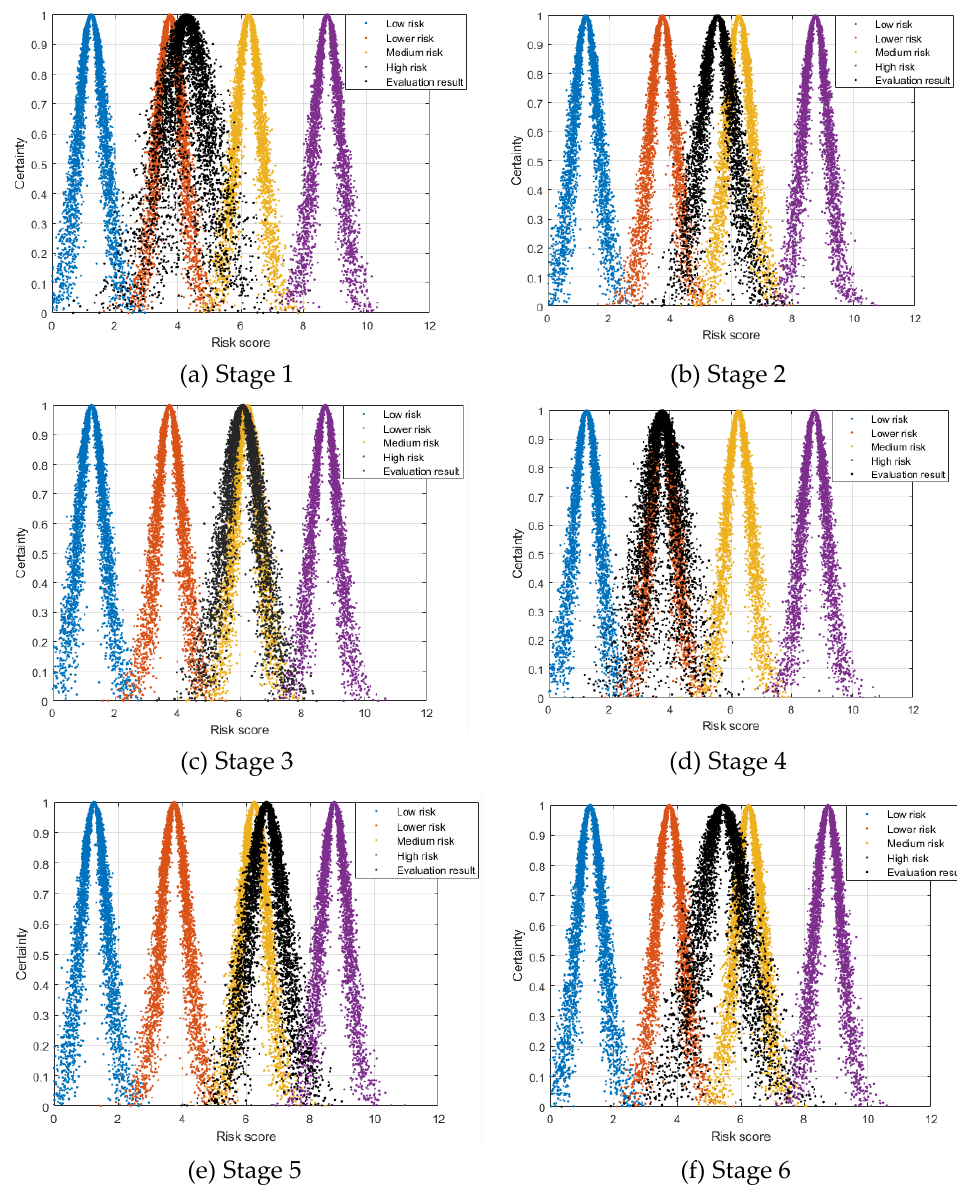
Figure 4. Cloud Chart of Primary Indicator Evaluation ( a ) – ( f ).